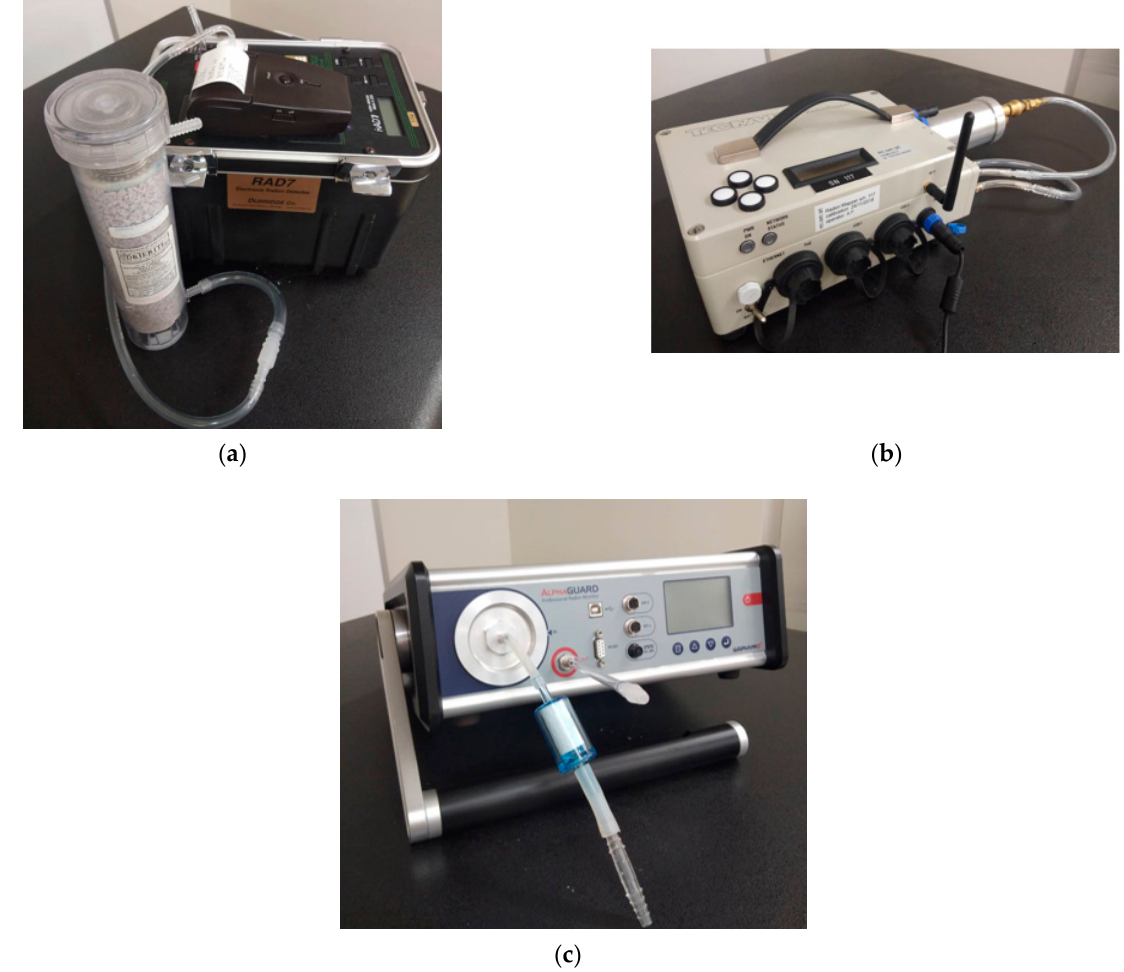
Figure 1. Illustration of ( a ) an electrostatic collection radon–thoron monitor (RAD7), ( b ) a single scintillation-cell radon and thoron monitor (Radon Mapper), and ( c ) an ionizing-chamber radon and thoron monitor (AlphaGUARD) used for the performance test in the present study.